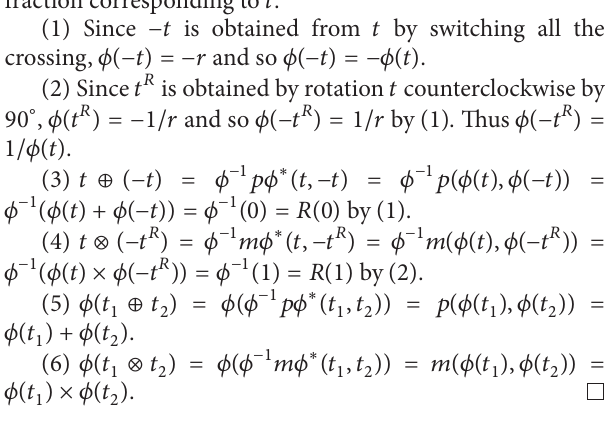
Figure 5: Infinite periodic tangle 𝑅(3,2, 1) .